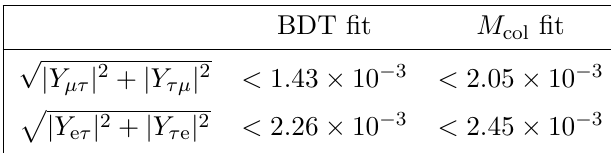
Table 9 . 95% CL observed upper limit on the Yukawa couplings, for the main analysis (BDT (cid:12)t) and the cross check ( M col (cid:12)t) method.